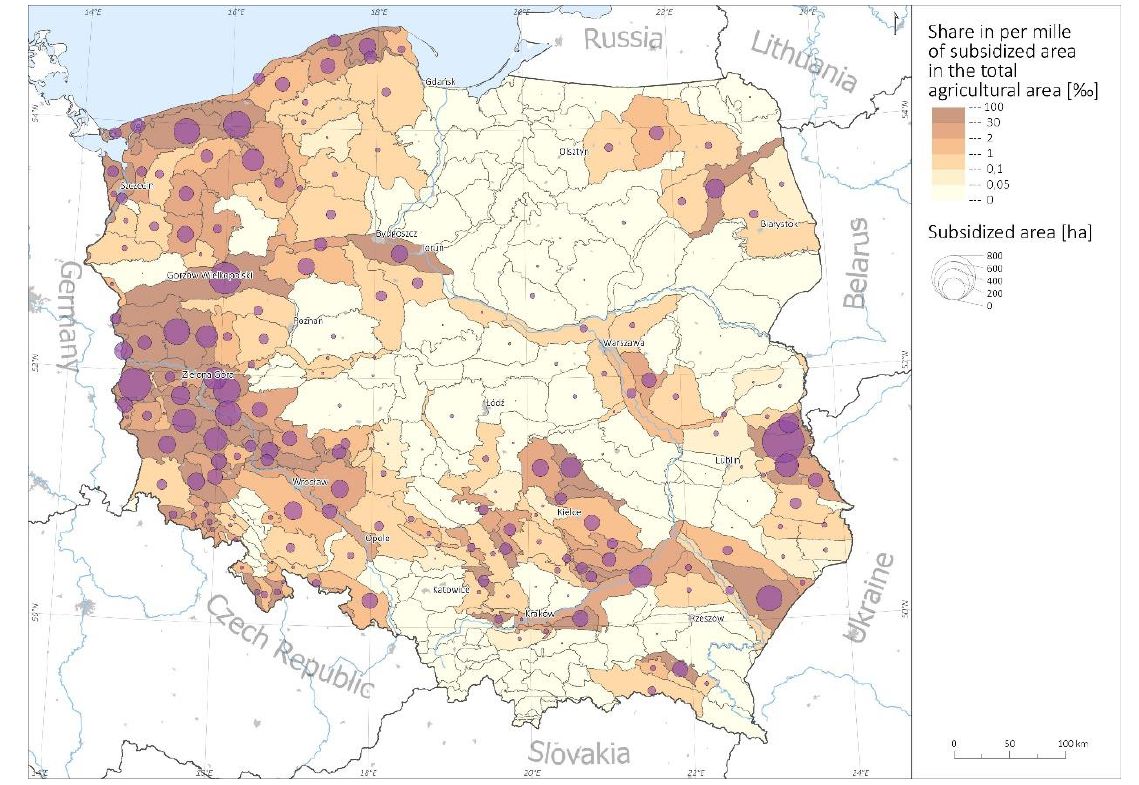
Figure 3. Area of land subsidised in support of protection of Variably wet Molinion litter meadows and their share in the total area of agricultural land in mesoregions (Source: Authors based on ARMA data).